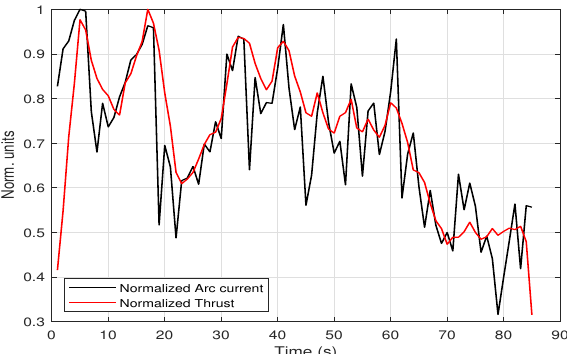
Figure 11. Normalized thrust and arc current versus time, measured during a single firing